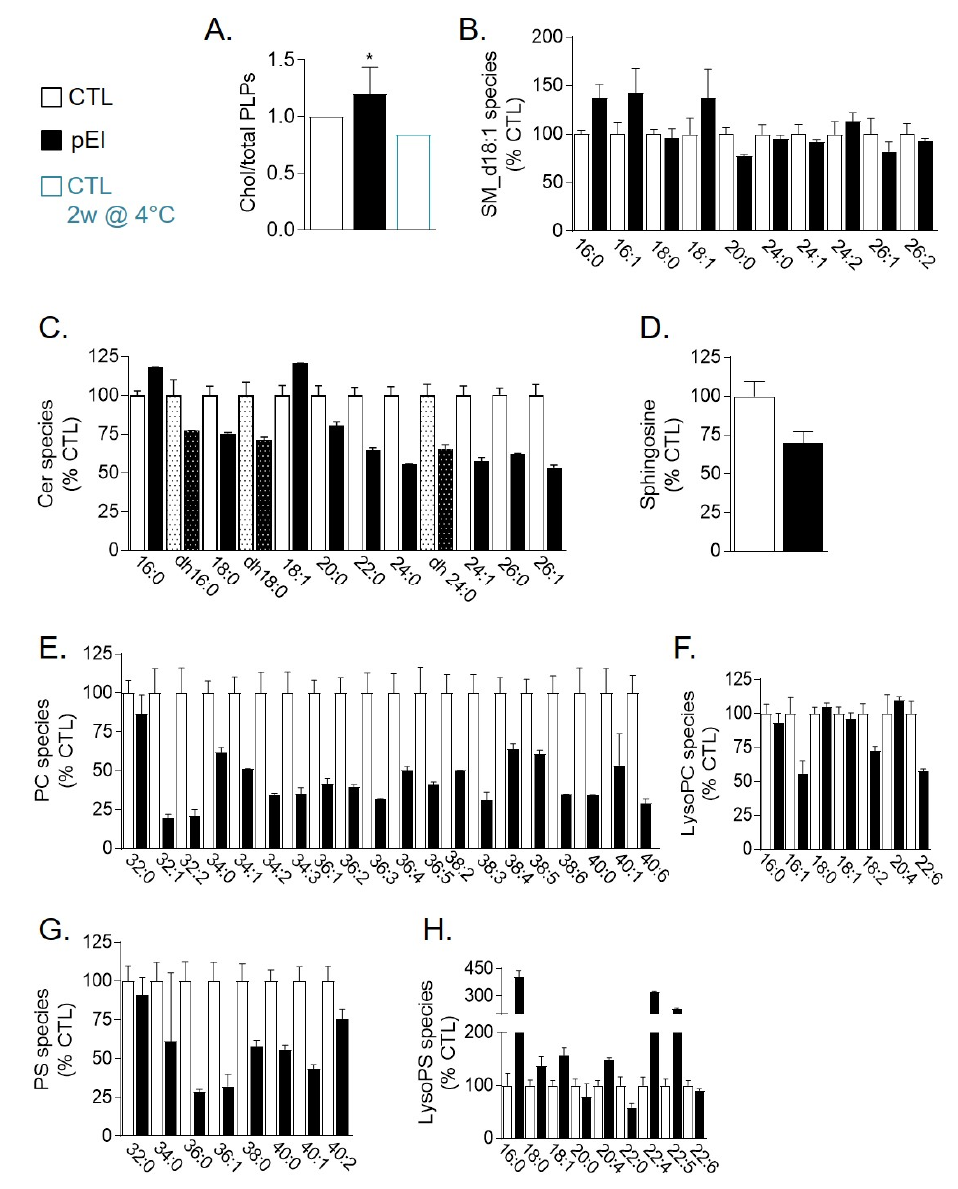
Figure 4. RBC membranes from patient pEI presented a lower abundance of phosphatidylcholine and phosphatidylserine species vs. an increased content in cholesterol and lysophosphatidylserine species. ( A ) Cholesterol content. RBCs were washed, lysed and assessed for cholesterol (chol) and total phospholipids (PLPs). Results are expressed as cholesterol/PLP ratio (chol/PLPs). Data are means ± SEM of 4 independent experiments, each in triplicate (except for blood upon storage at 4 ◦ C). Mann-Whitney test. ( B , E – H ) Content in sphingomyelin (d18:1 D-erythro-sphingosine backbone), phosphatidylcholine (PC), lysophosphatidylcholine (lysoPC), phosphatidylserine (PS) and lysophosphatidylserine (lysoPS) species. RBCs were washed, lysed, extracted for lipids and assessed by lipidomics. ( C , D ) Ceramide, dihydroceramide (dotted columns) and sphingosine species assessed by HPLC-MS on washed, lysed and lipid-extracted RBCs. Species are classified based on fatty acid length and unsaturation number and results are expressed as percentage of controls (CTL, mean of 9 healthy women). * , p <